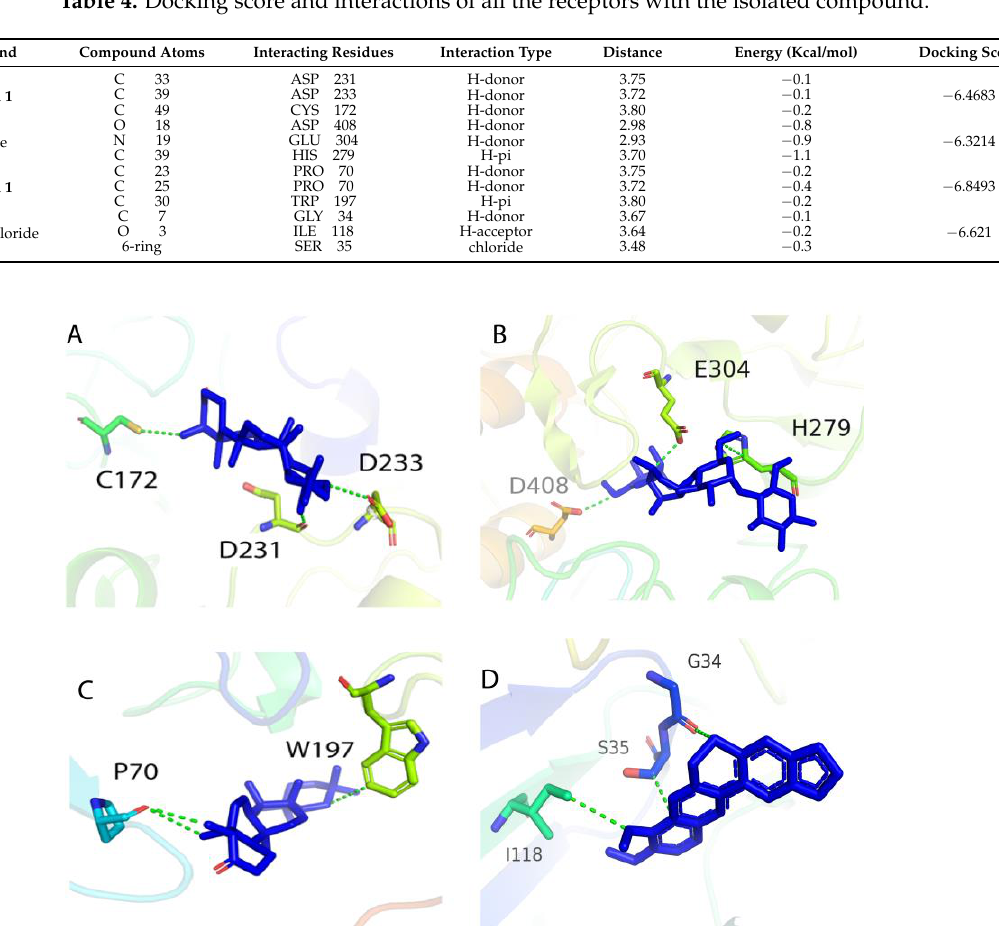
Figure 3. Three-dimensional interactions of compound 1 and reference compounds with the target protein: ( A , B ) α -glucosidase and ( C , D ) β -secretase.